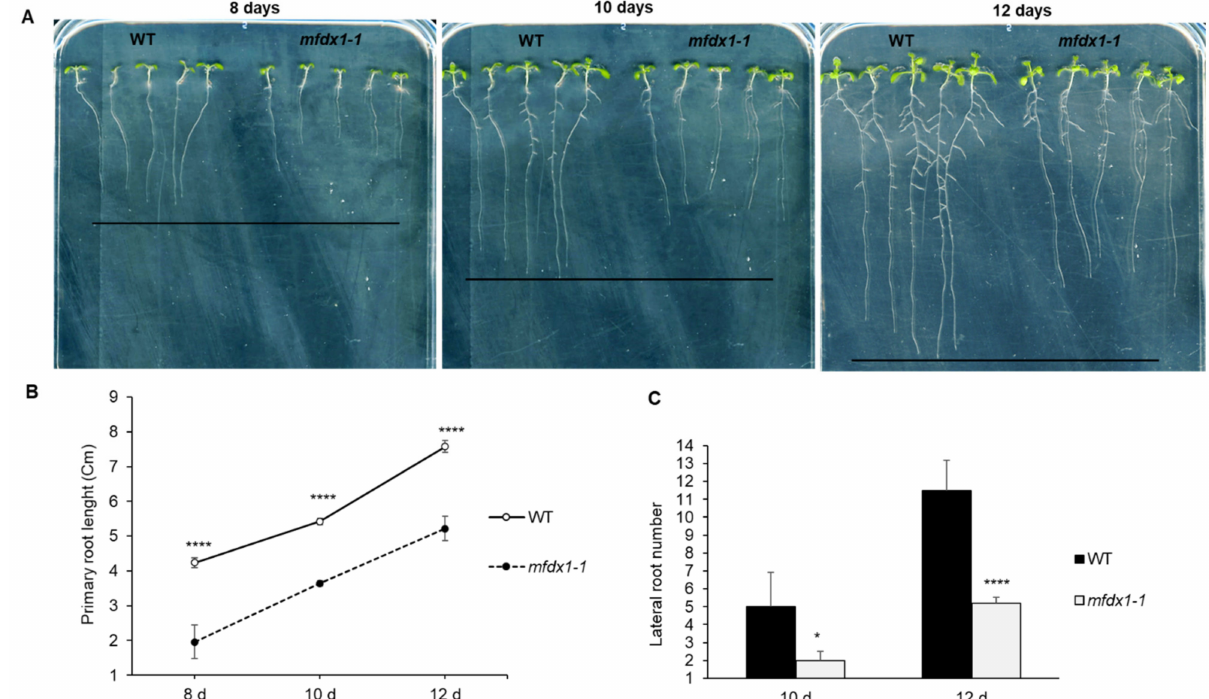
Figure 5. The Fe-S cluster mutant mfdx1-1 affects primary root length and lateral root number in Arabidopsis. ( A ) Arabidopsis WT (Col-0) and the mfdx1-1 mutant were germinated and seedlings were grown vertically on 1 ⁄ 2 MS medium with agar until pictures were taken at 8, 10, and 12 days. Visible differences in root length and lateral root number between the mfdx1-1 and WT can be observed. Photographs of representative WT and mfdx1-1 were taken at different days after germination. ( B ) Quantification of primary root length in cm using ImageJ software. Error bars represent SE from 5 seedlings. Asterisks denote statistical significance according to Student’s t test (**** p -value < 0.0001). Experiment was performed twice with similar results. ( C ) Quantification of lateral root number. Error bars represent standard error from 5 seedlings. Asterisks denote statistical significance according to Student’s t test (* p -value < 0.05, **** p -value < 0.0001). Experiment was performed twice with similar